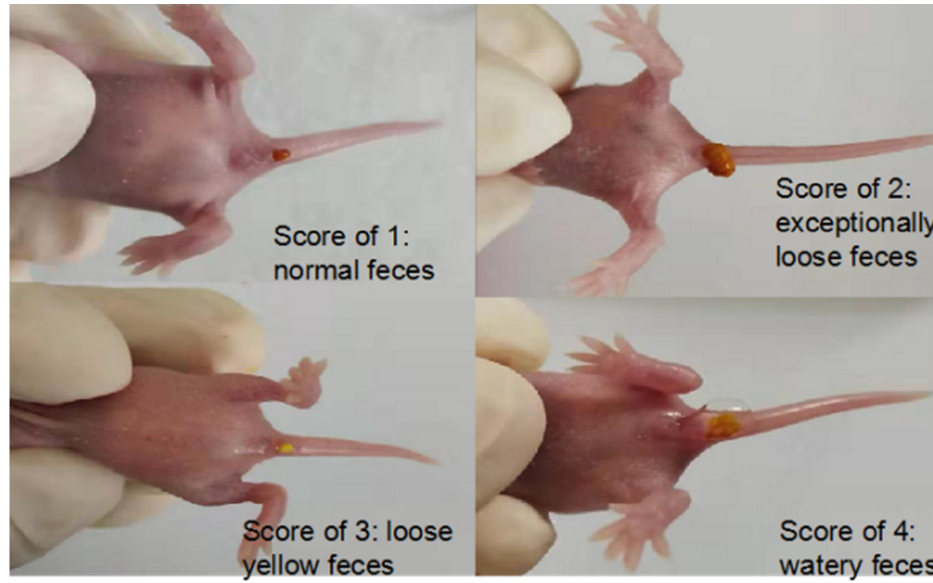
Figure 18. Diarrhea in suckling mice.